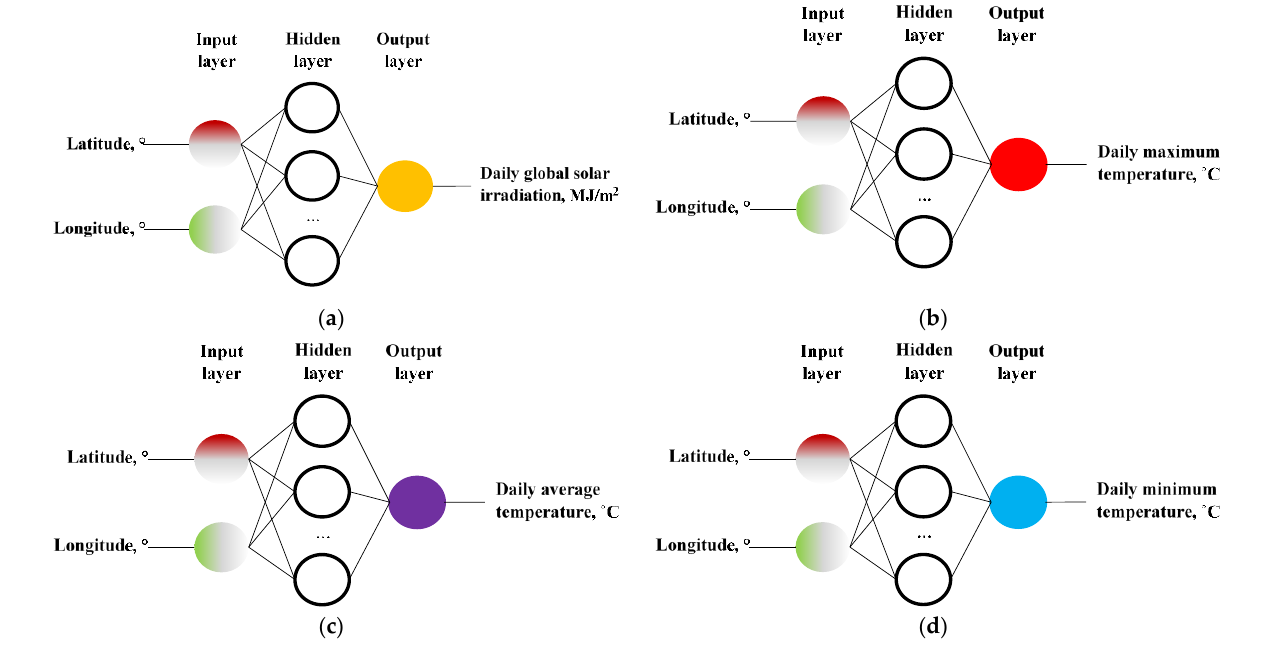
Figure 2. The architecture of the models evaluated with Artificial Neural Networks (ANN). Layers (input-hidden-output) (2- 1…4 -1) based on the input variables [latitude and longitude] to individu- ally estimate: ( a ) daily global solar irradiation; ( b ) daily maximum temperature; ( c ) daily average temperature; ( d ) daily minimum temperature.